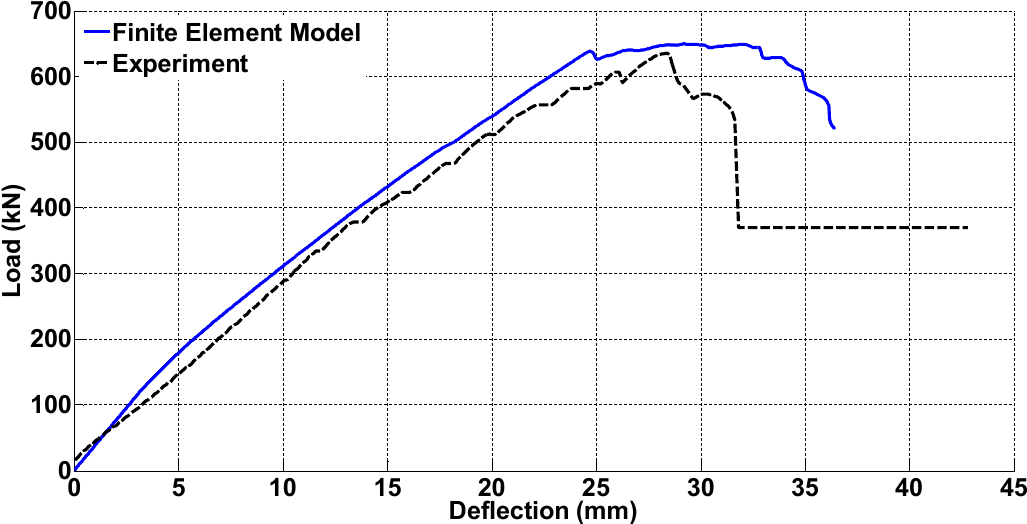
Figure 11. Load versus deflection diagrams of the experiment and the FEM.